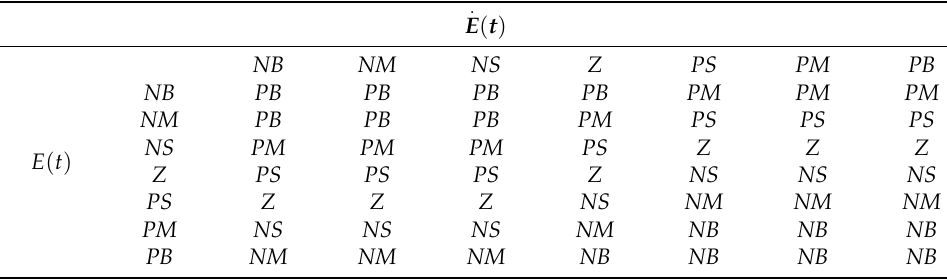
Figure 11. Gaussian membership function for Table 2. Fuzzy controller gains tuning